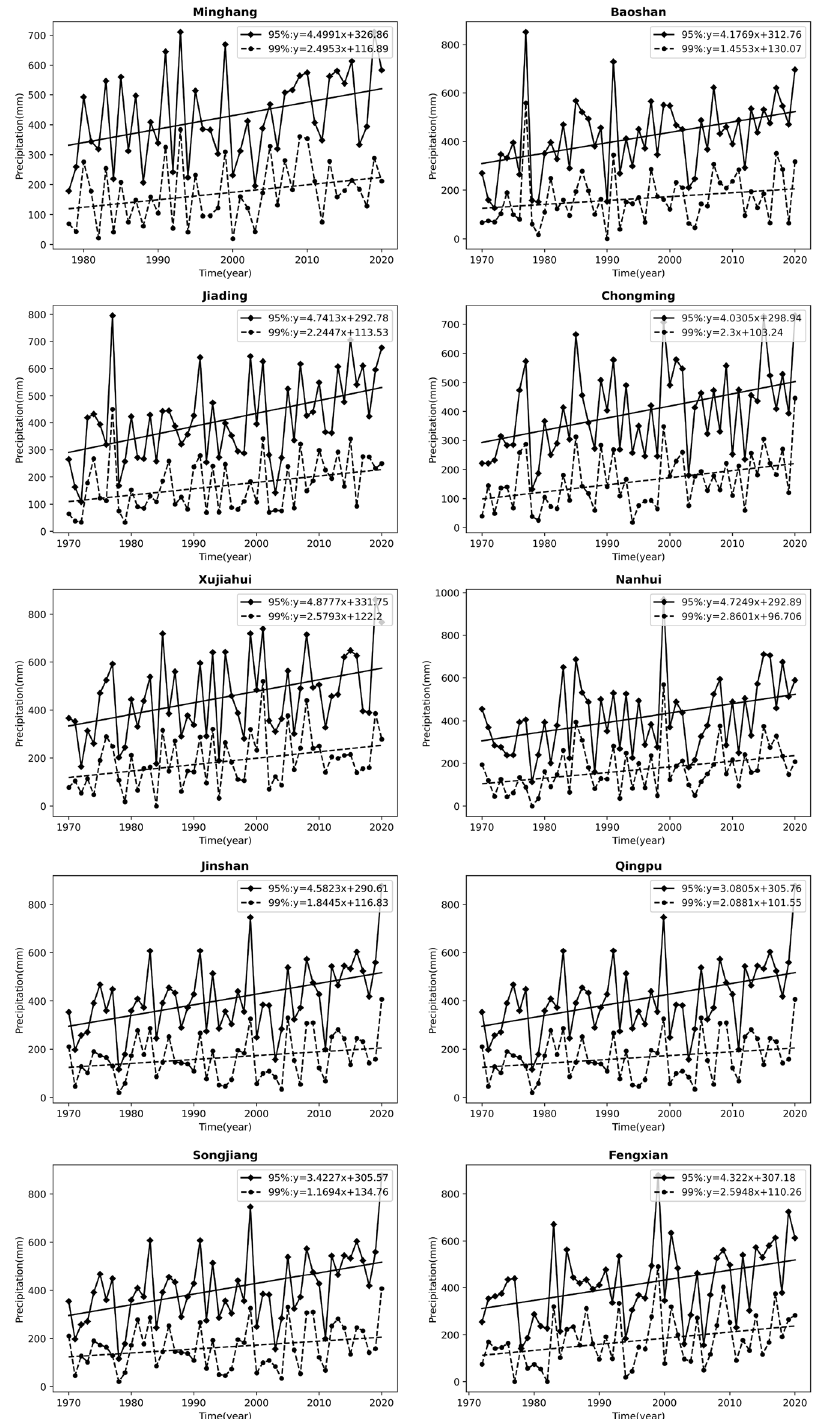
Figure 3. Trends of extreme precipitation under different threshold conditions at each